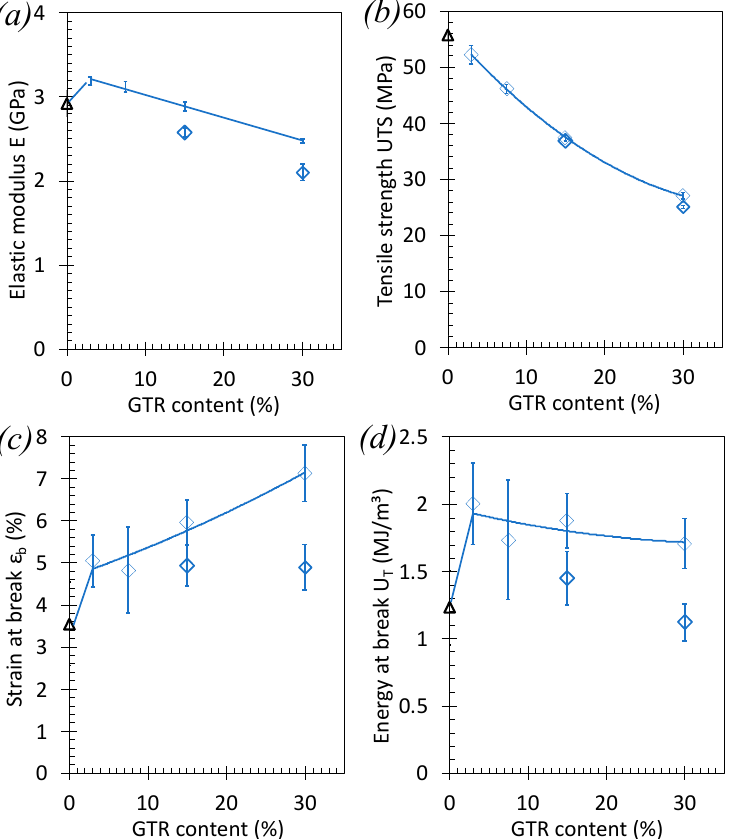
Figure 10. Effect of the GTR content on the tensile properties of PLA/GTR blends. ( a ) Elastic modulus, E T , ( b ) yield strength σ y , ( c ) strain at break, ε b , and ( d ) energy at break, U T , from tensile test performed at 10 mm . and at room temperature on the neat PLA (black triangle symbols), PLA/GTR c in presence of 1.5 wt% of DCP (blue diamond symbols). All blends were processed at 170 °C in presence of Irganox (0.2 wt% of total amount of material).